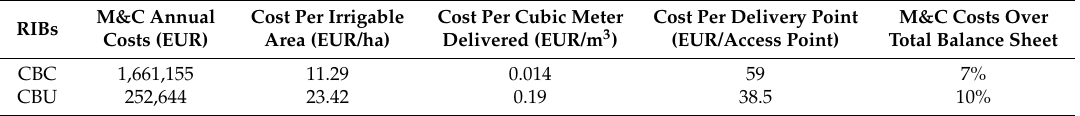
Table 7. Results of the evaluation of the annual cost of the M&C service.